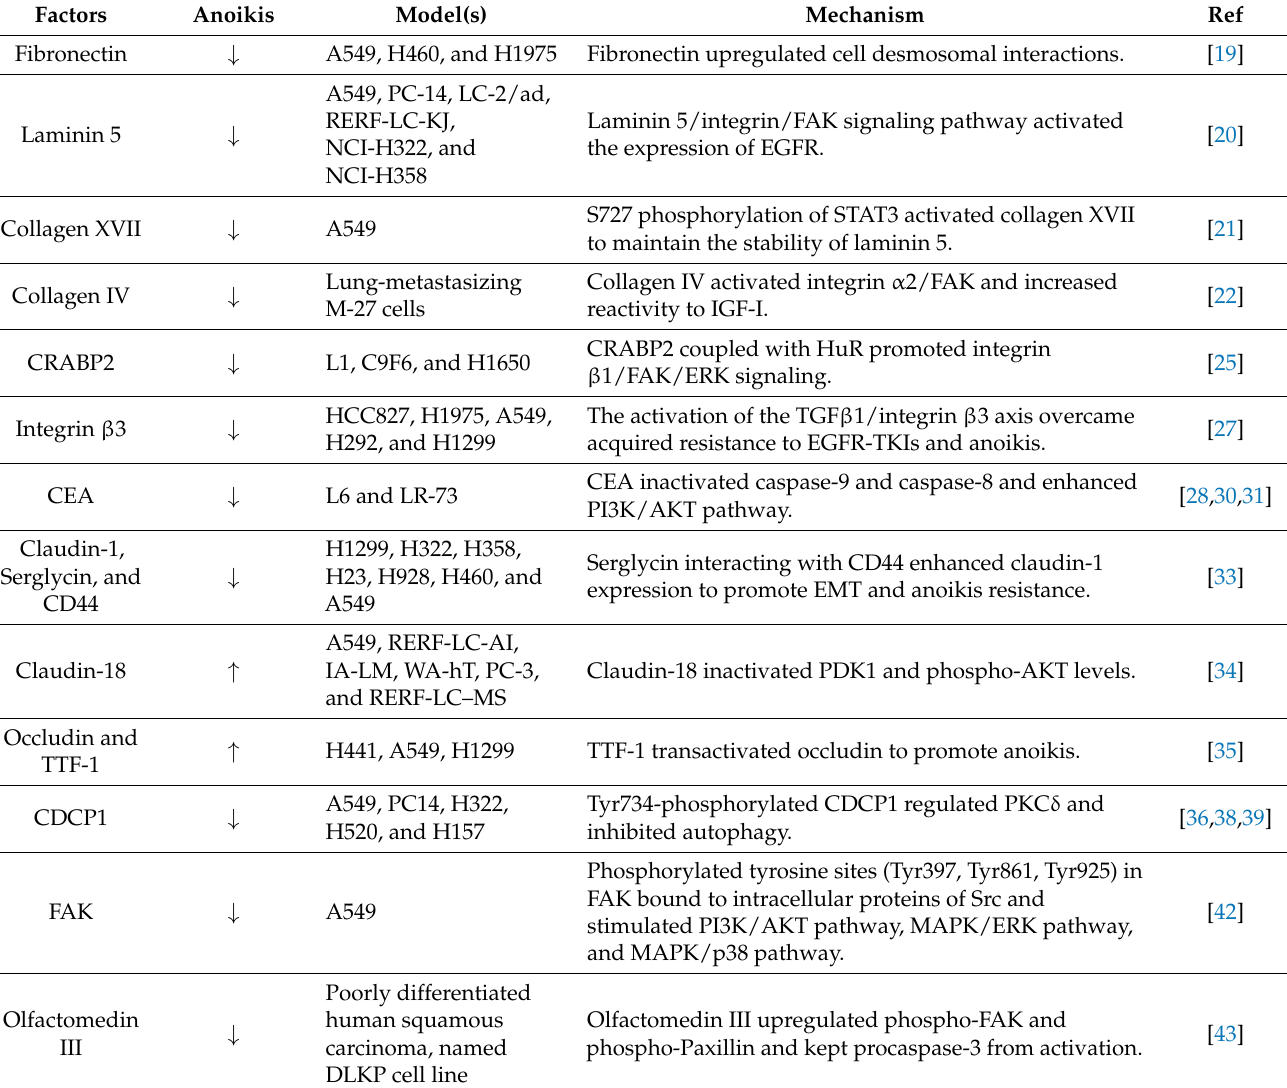
Table 1. Molecular factors and mechanisms related to anoikis in lung